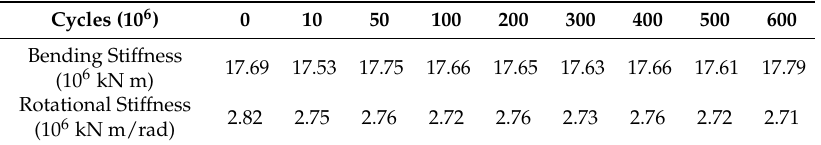
Table 6. The bending stiffness and rotational stiffness versus cycles.